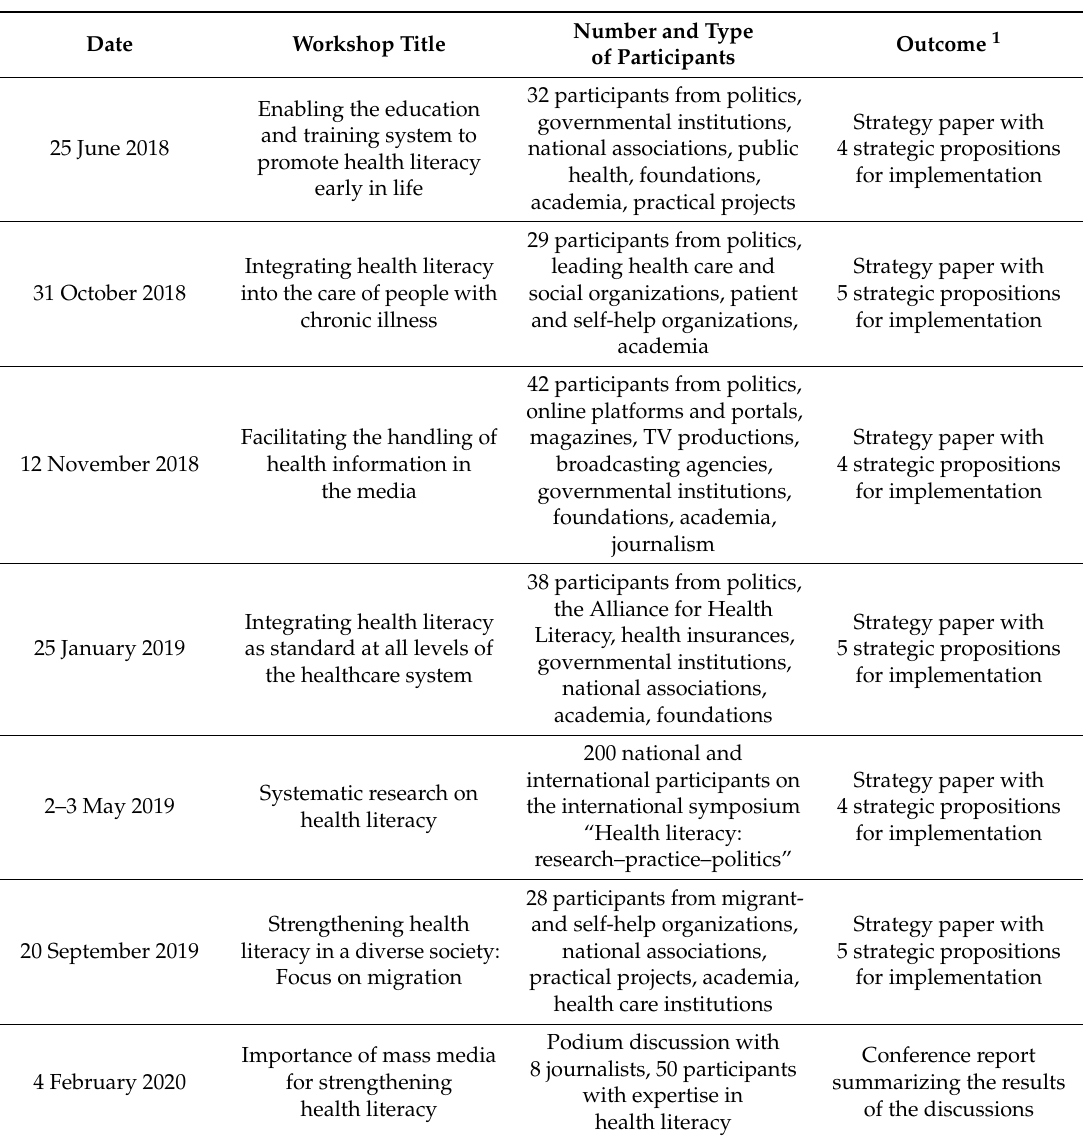
Table 1. Workshop